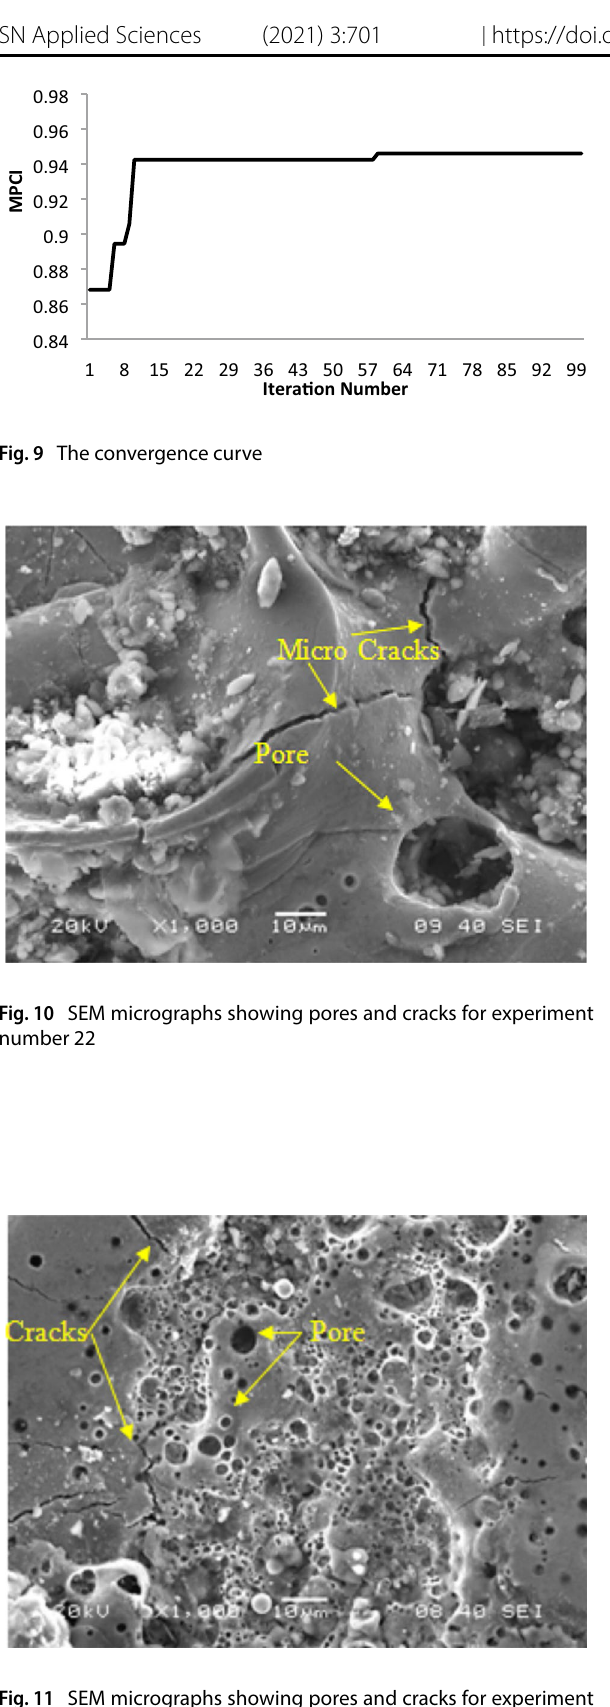
Fig. 11 SEM micrographs showing pores and cracks for experiment number